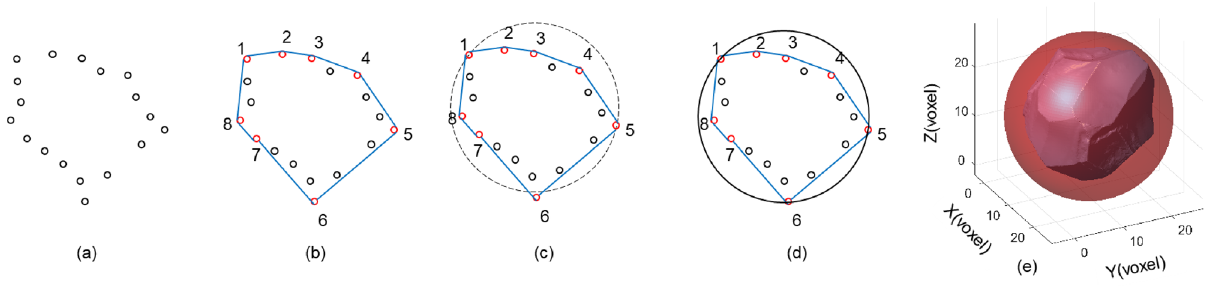
Fig. 8 The process of determining the minimum circumscribed sphere